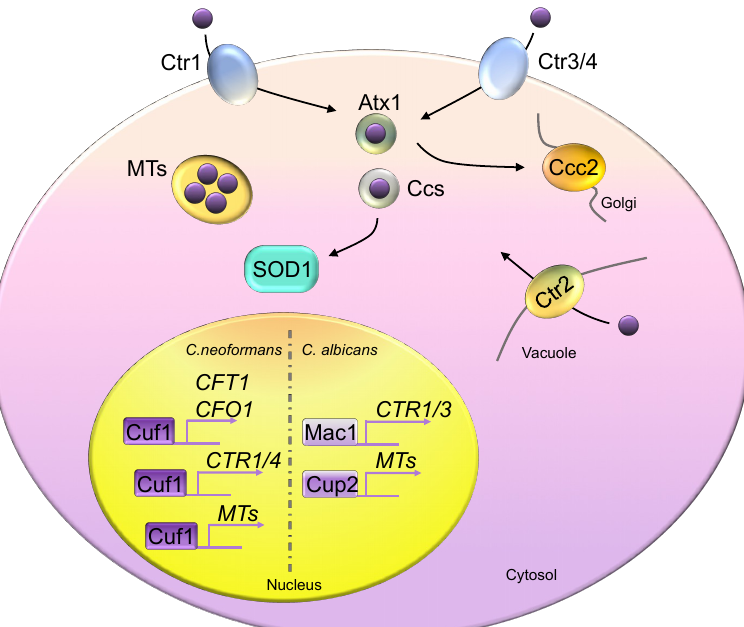
Figure 2. Copper homeostasis in fungi. Fungal cells generally encode two high-affinity copper importers, Ctr1 and Ctr3 (Ctr4), except in Candida albicans , which possesses only the Ctr1 homolog. Atx1 and Ccs are two copper chaperones, delivering copper to Ccc2 and Sod1, respectively. Metallothioneins (MTs) are copper detoxification proteins that bind excess copper. Ctr2 is a vacuolar copper transporter, pumping copper from the vacuolar space into the cytosol compartment. Mac1 controls the copper depletion responses of Saccharomyces cerevisiae and C. albicans by activating the expression of copper transporters. Saccharomyces cerevisiae Ace1 responds to copper toxicity and induces MT expression. C. neoformans Cuf1 controls responses in both copper-rich and copper-poor environments. Cuf1 constitutively binds to the promoter sequences of CFT1 and CFO1